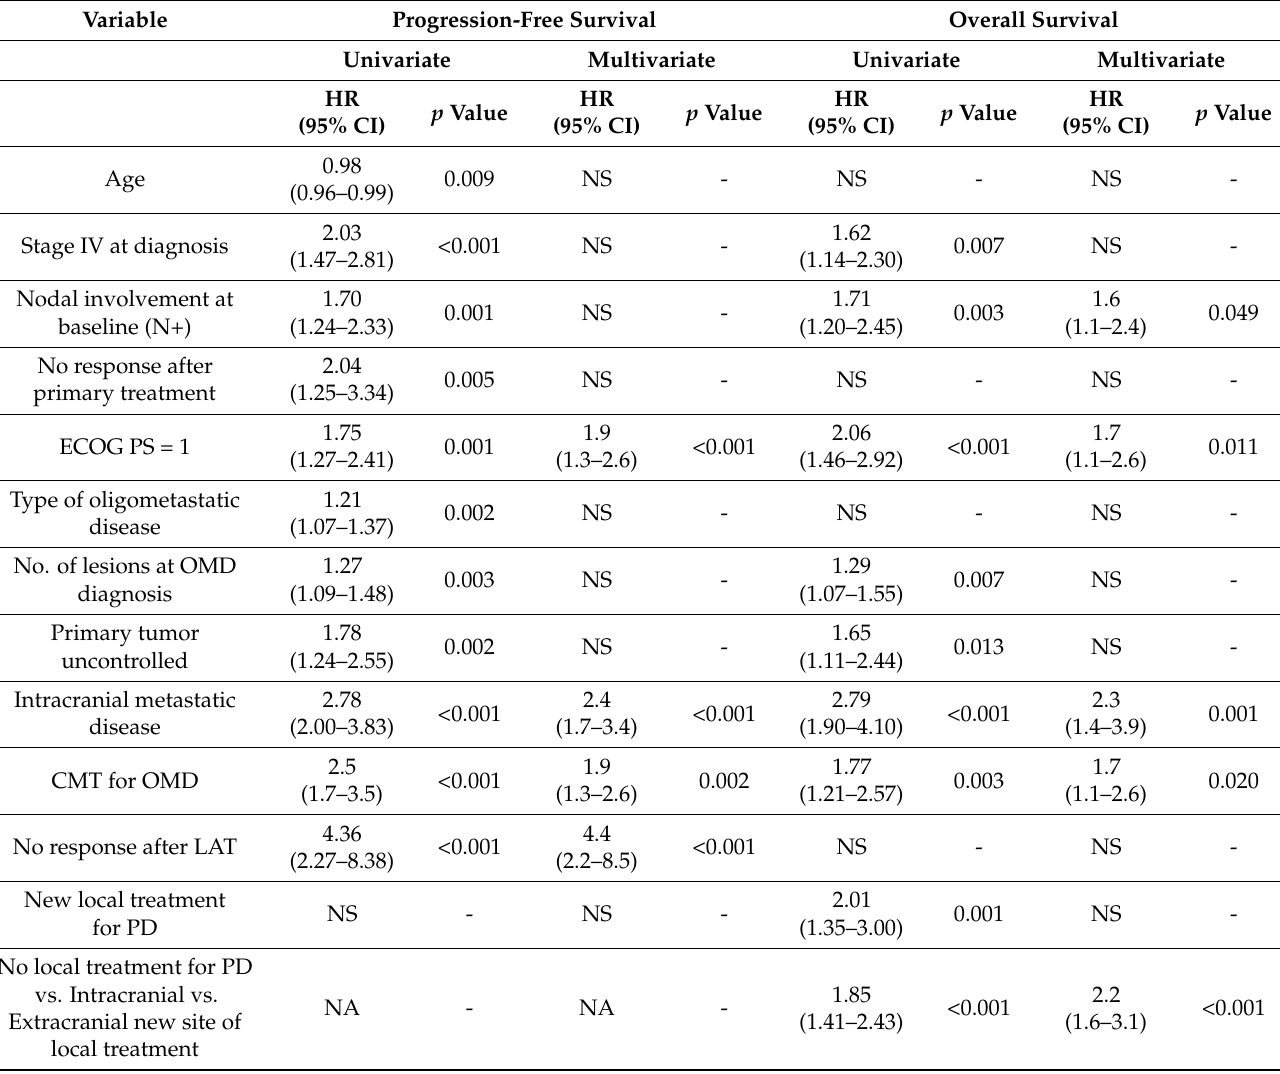
Table 3. Univariate and Multivariate Cox Regression of Factors Predicting Progression-Free Survival and Overall